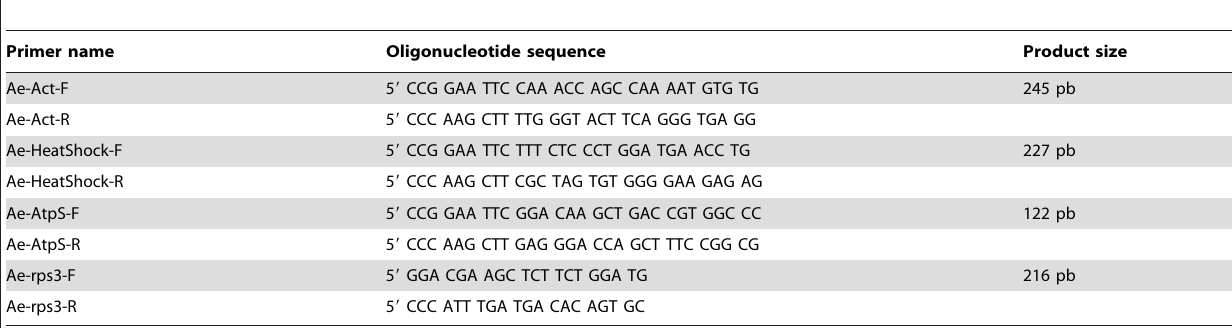
Table 3. Sequence of specific oligonucleotides used to amplify ATP synthase beta subunit, actin and heat shock protein